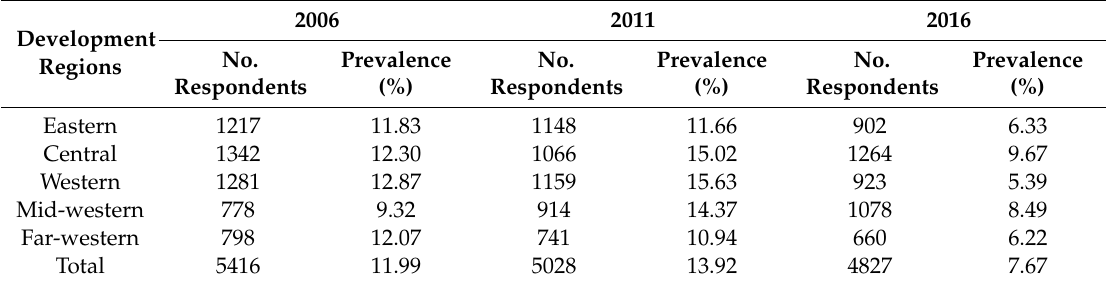
Table 2. Observed diarrhea prevalence among children under 5 years old in development regions of Nepal, categorized by survey